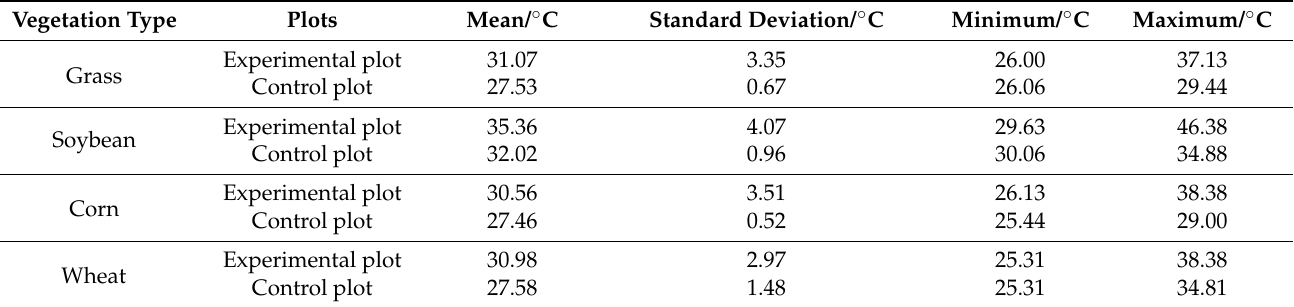
Statistical characteristic values of temperature in the section of experimental and control